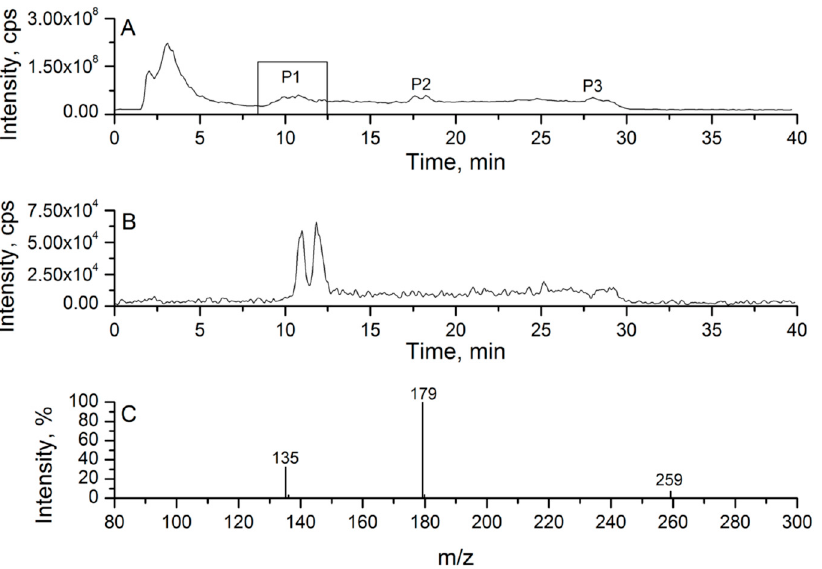
Figure 4. ( A ) TIC of mixture after synthesis of caffeic acid sulfate; ( B ) chromatogram of caffeic acid sulfate obtained after purification; ( C ) fragmentation spectra of caffeic acid sulfate.